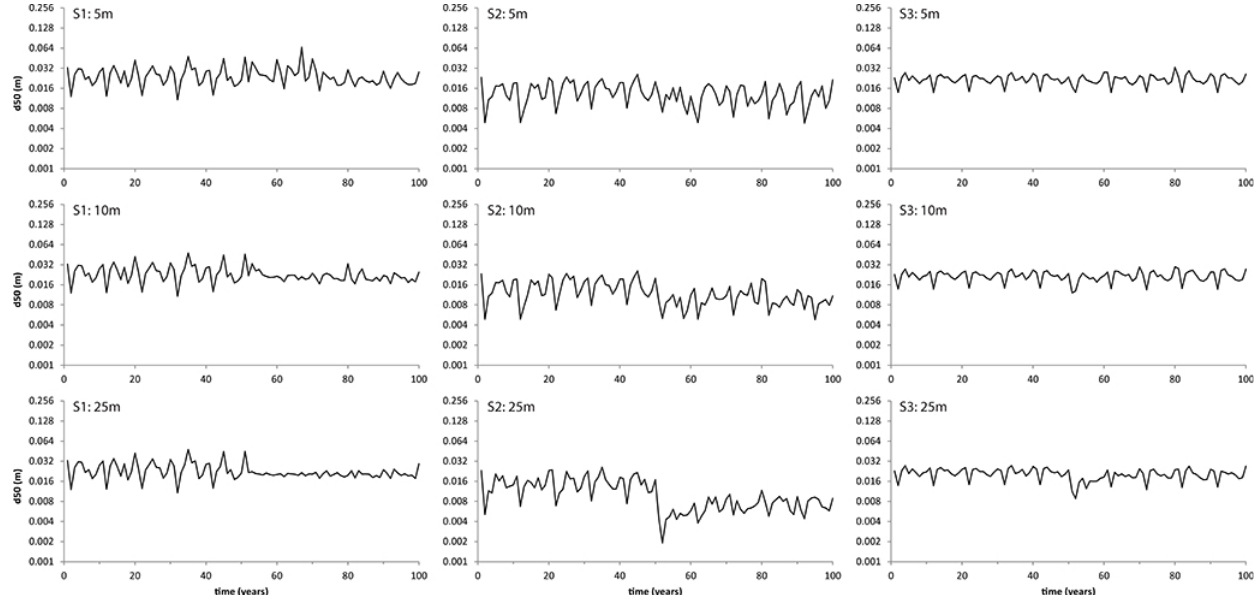
Figure 6. Median annual grain sizes for S1, S2 and S3 for 5, 10 and 25m uplift simulations. Values are calculated by summing total daily sediment yields for each of 9 grain sizes output by CAESAR, over a simulated year. This was carried out in preference to calculating daily median grain sizes and then averaging this over a year, which would skew the median grain size by over-weighting the contribution of days with small daily sediment